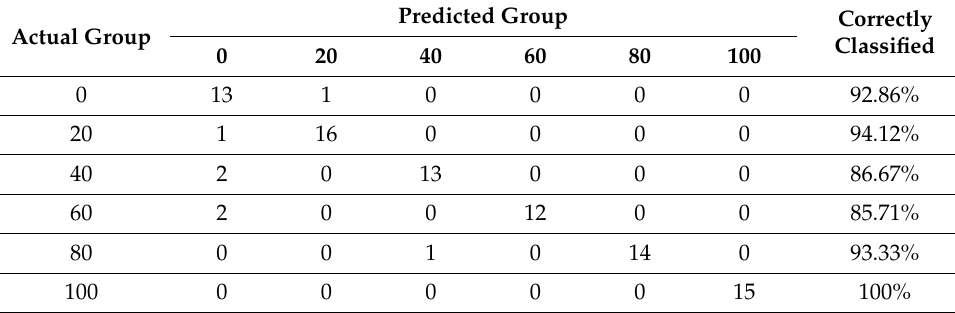
Table 6. Correctly classified cases in training dataset.